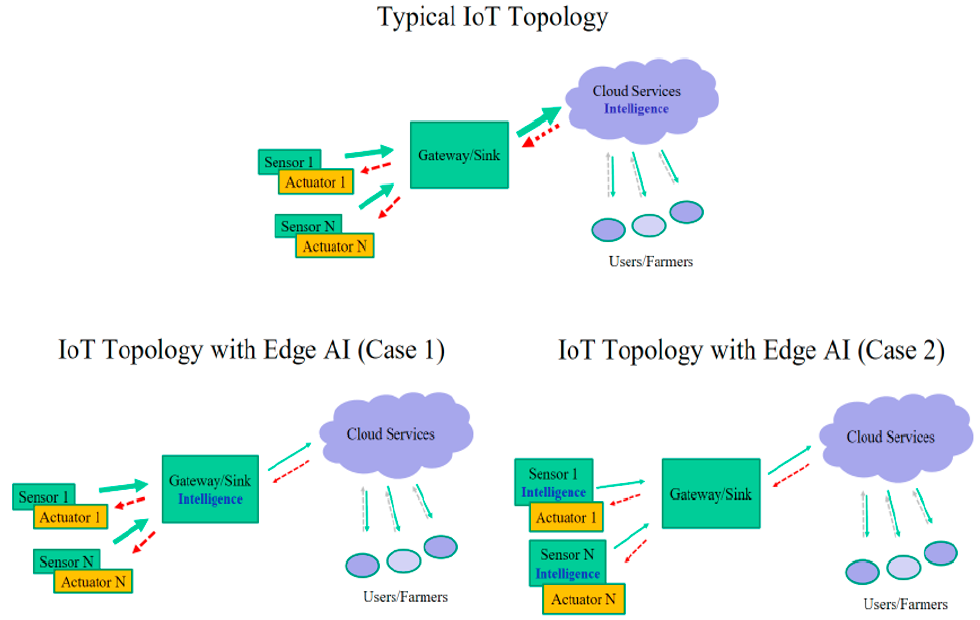
Figure 1. Network traffic reductions while migrating from cloud-based to edge AI solutions, with the intelligence capabilities to be ported on the gateway node ( case 1 ) and the sensor nodes ( case 2 ).